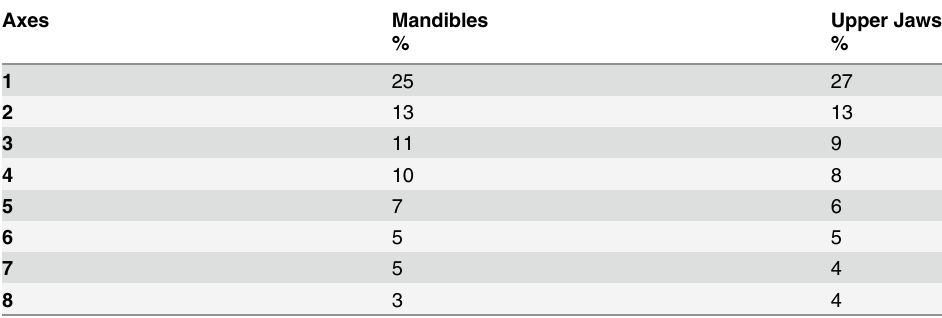
Table 3. Summary of variation explained by PC axes. Axes